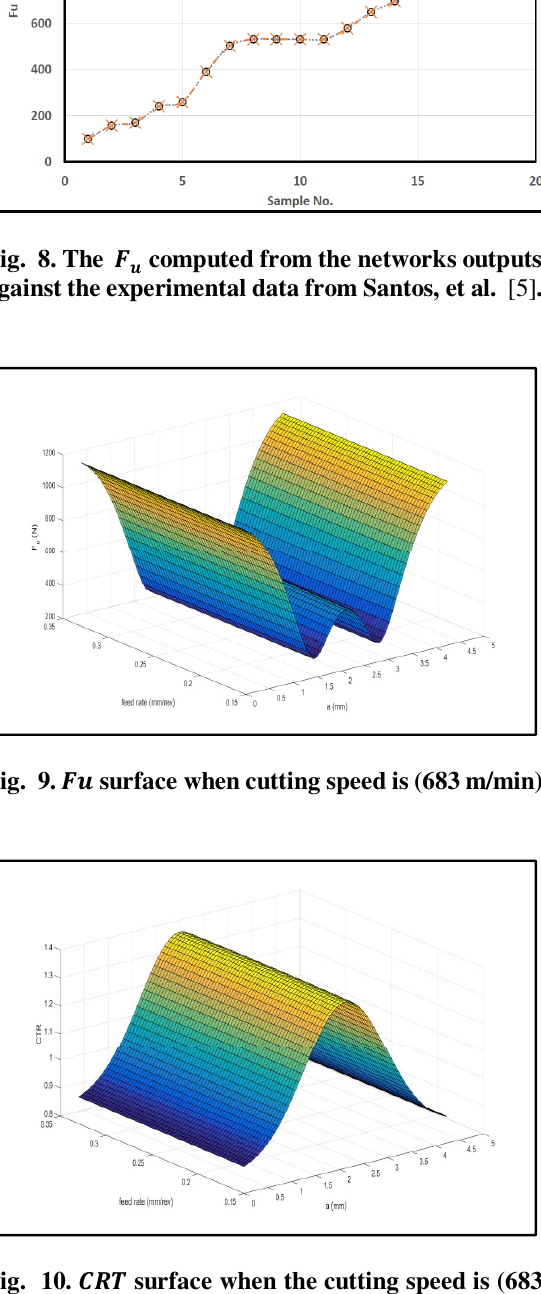
Fig. 7. The neural network for CTR response against the experimental data from Santos, et al. [5] .